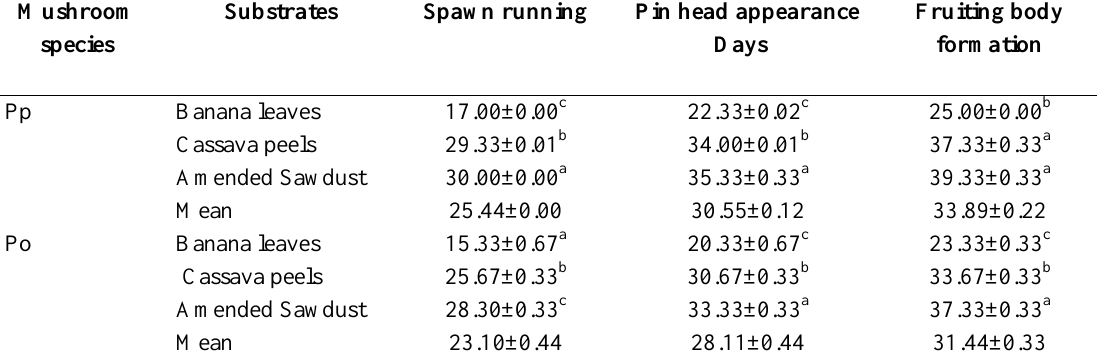
Table 1: Effects of different substrates on growth and yield performance of Pleurotus pulminarius and Pleurotus ostreatus. Mushroom